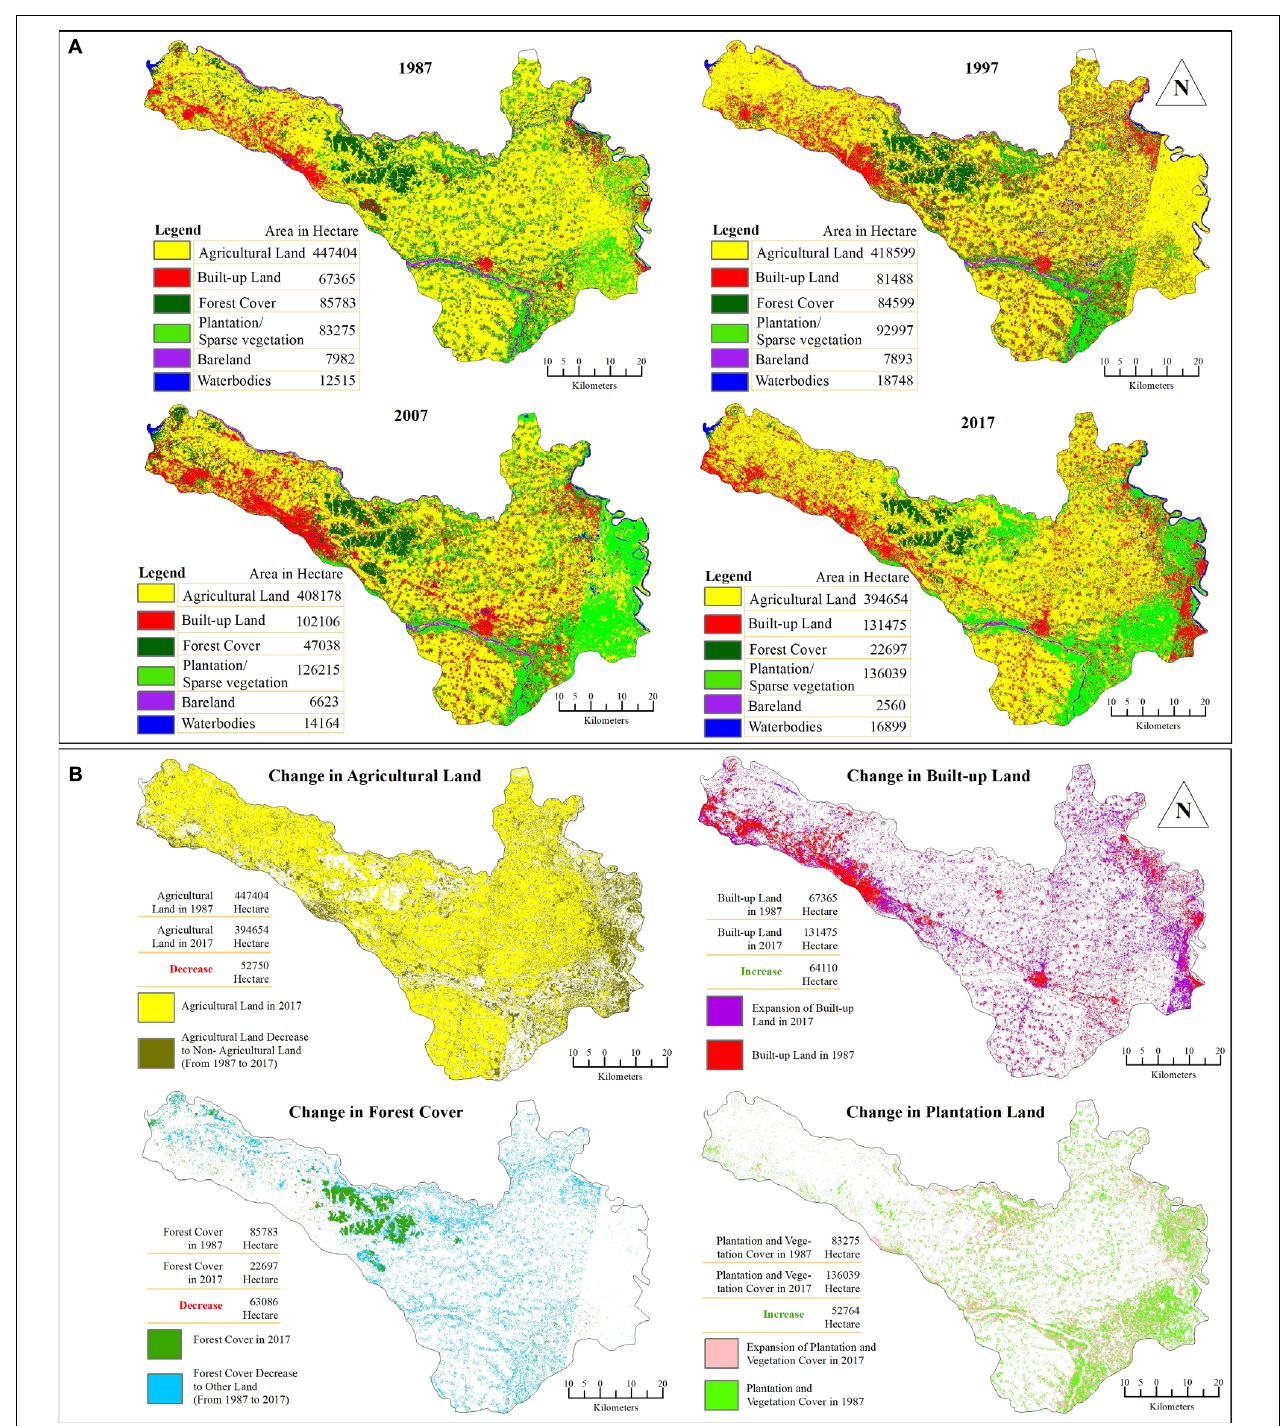
FIGURE 2 | (A) LULC (1987, 1997, 2007, and 2017). (B) LULC change (1987–2017). Author, 2019. (Landsat 5 and 8 satellite imagery, USGS). Author, 2019. (Area calculated from satellite Landsat imagery by supervised classification method in Erdas Imagine 14 and ArcGIS).